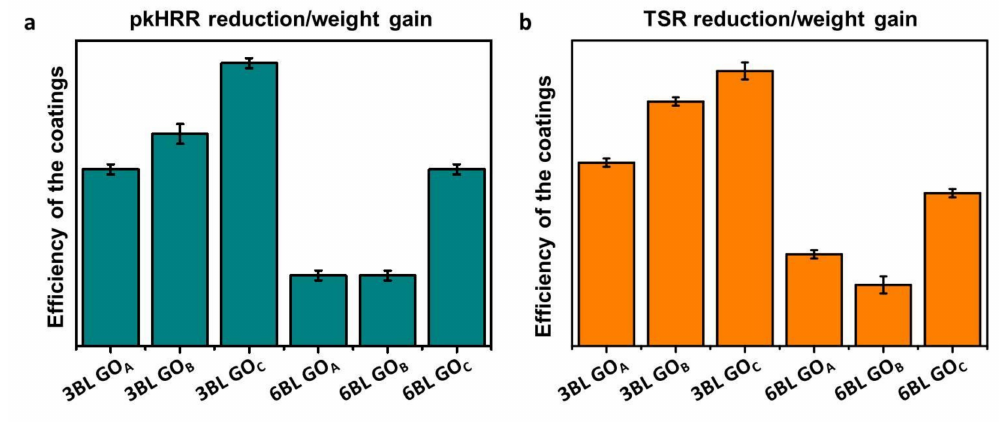
Figure 6. Coating flame-retardant efficiency as function of pkHRR reduction/weight gain ( a ) and TSR reduction/weight gain ( b ) for 3BL- and 6BL-treated